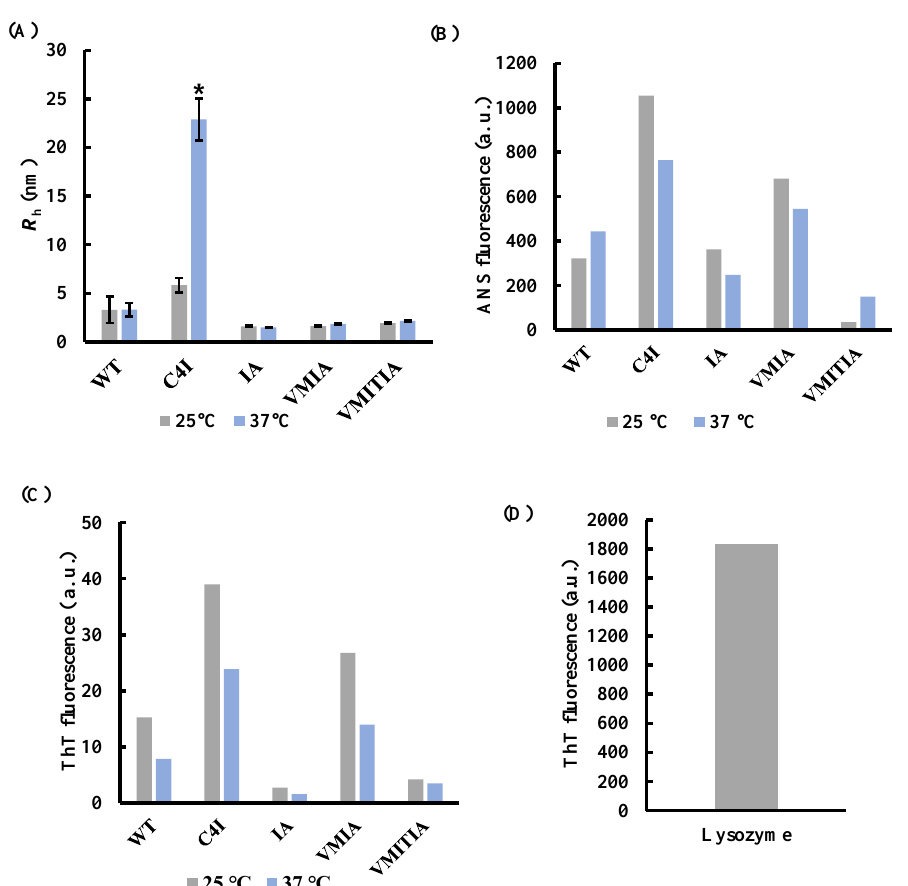
Figure 4. Analysis of the DENV3-ED3 variant aggregates. ( A ) Hydrodynamic radius ( R h , nm) of DENV-ED3 variants determined by DLS. Data represent the mean ± SEM ( n = 3). * p < 0.05 vs. WT at 37 ◦ C. ( B ) ANS fluorescence intensity. ANS (20 µ M) was added at to the DENV3-ED3 proteins (50 µ M); ( C , D ) ThT fluorescence intensity. ThT (10 µ g/mL) was added to ( C ) 50 µ M DENV3-ED3 proteins and ( D ) 50 µ M